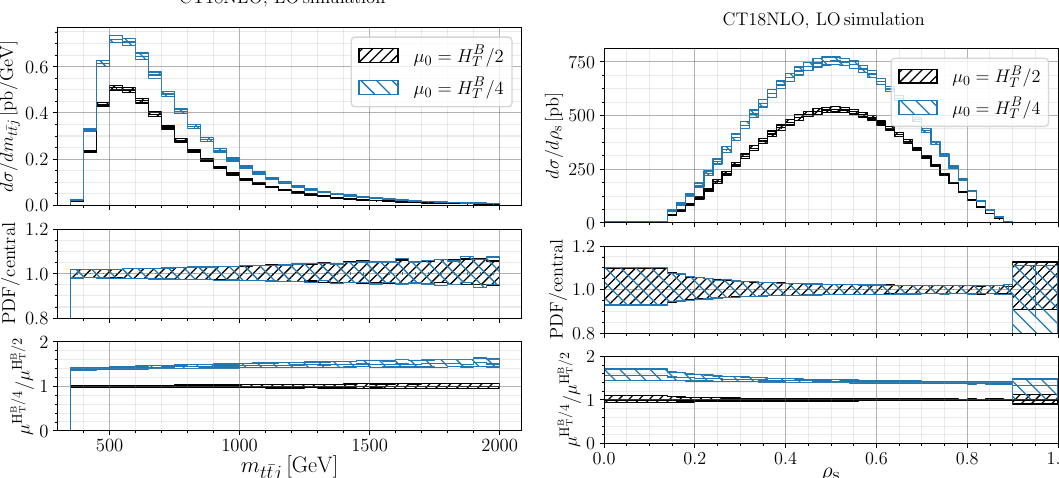
Figure 20 . Central predictions for the m (left) and ρ s (right) distributions in a LO computation t ¯ tj with the scales µ 0 = H B / 2 (black) and µ 0 = H B / 4 (blue), using as input in both cases the CT18 T T NLO PDFs + α s ( M Z ) value and two-loop evolution of α s . PDF uncertainty bands computed according to the CT18 prescription and rescaled to 68% C.L. are also